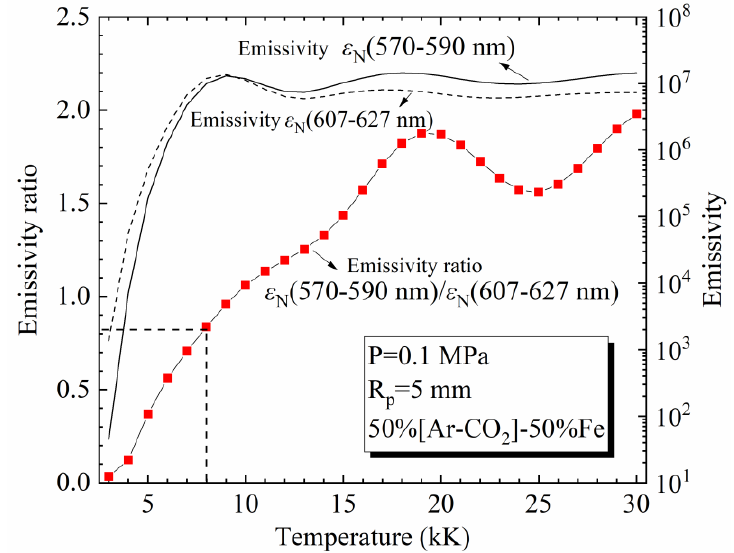
Figure 6. Net emission coefficients of the spectral intervals of 570–590 nm (line) and 607–627 nm (dash) and their emissivity ratio (line-square) at 0.1 MPa and R p = 5 mm.